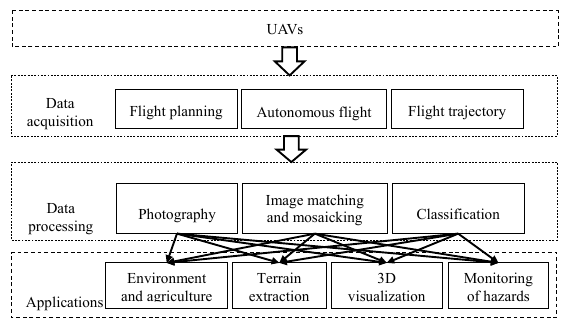
Figure 1. The frameworks of application from UAVs Figure 3. Framework for research on UAVs